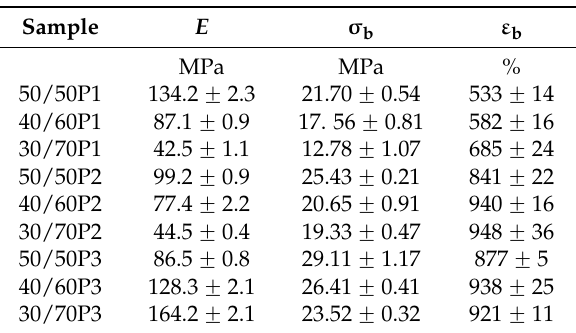
Figure 6. Representative stress–strain curves for PTT- b -PEOT copolymers containing 50 ( a ) and 70 ( b ) wt % of PEOT flexible segments. Table 3. Tensile properties of PTT- b -PEOT copolymers